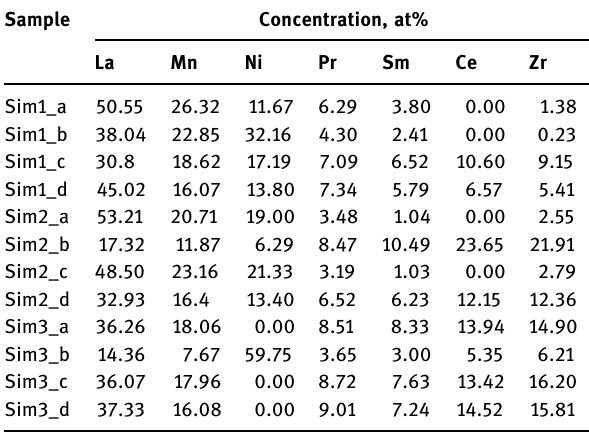
Table 2: Elemental composition of nanocomposite samples